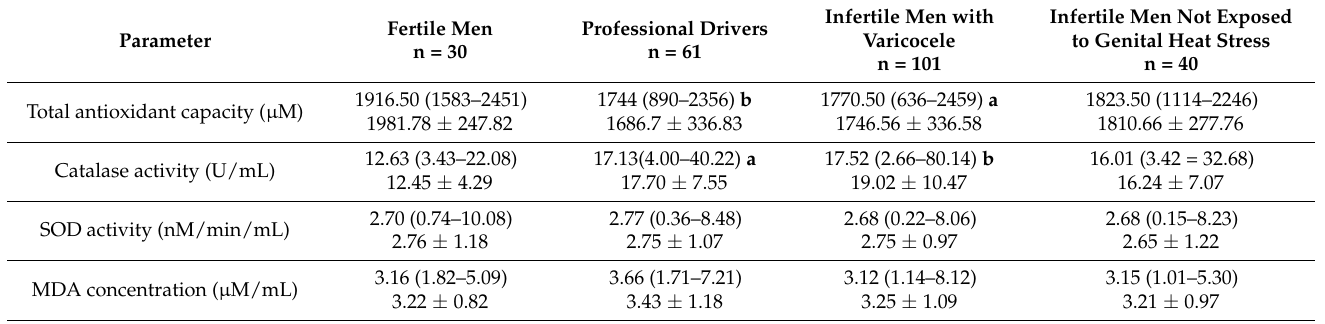
Table 1. Descriptive statistics and comparative analysis of oxidative stress parameters among the studied groups of